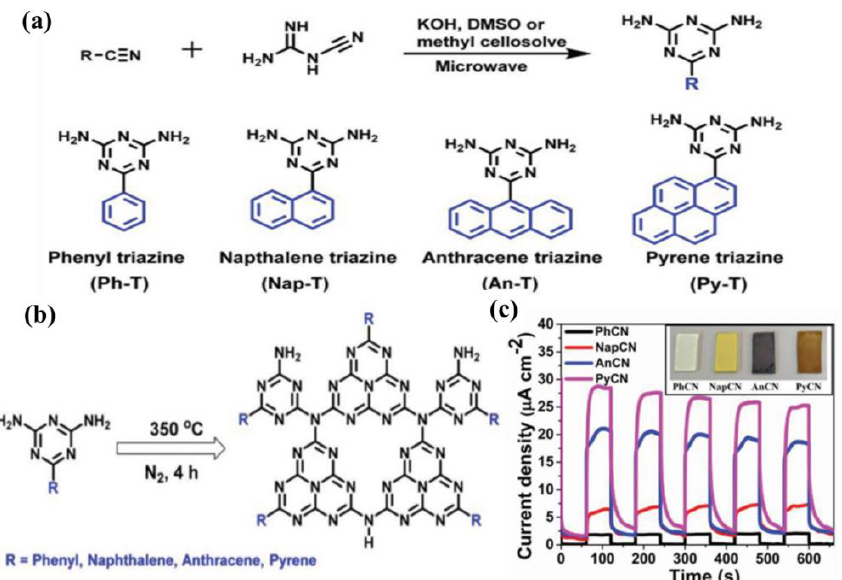
Figure 14. ( a ) Synthesis diagram of polycyclic aromatic triazines and their different molecular struc- tures. ( b ) Self-condensation of the corresponding monomers. ( c ) The photocurrent measurements of polycyclic aromatic hydrocarbons modified CNs (PAH-CN) drop-casted electrodes at 1.23 V vs. RHE (the inset shows the photographs of g − CN dissolved in tetrahydrofuran (THF) and drop-casted on FTO). Reprinted with permission from ref. [133] Copyright 2019